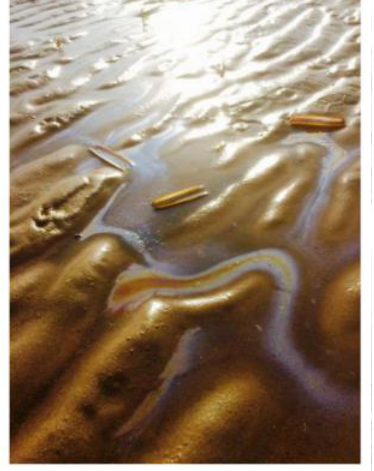
Figure 10. Oil traces on Hoylake